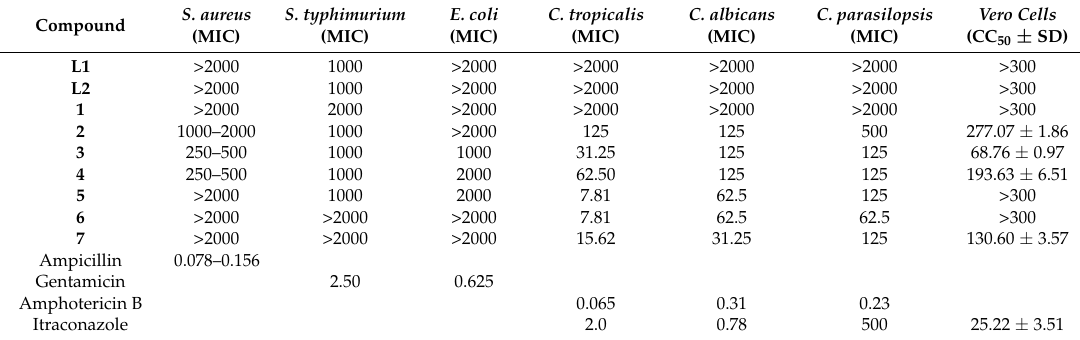
Table 3. Antimicrobial and cytotoxic activities of ligands and complexes (MIC, CC 50 ; µ g mL − 1 ).